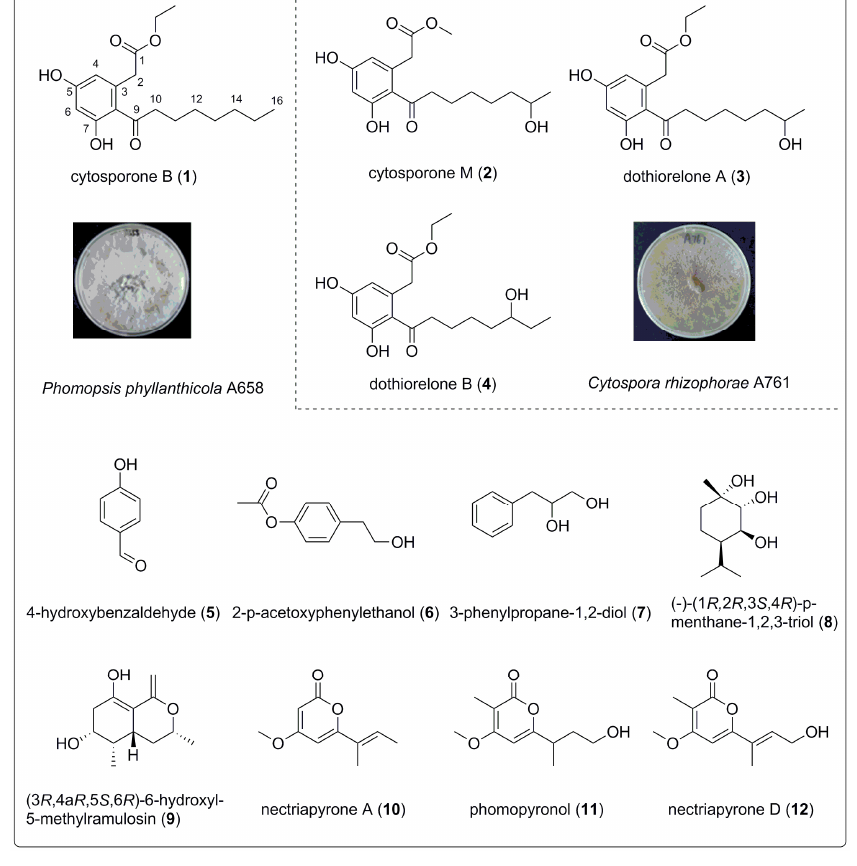
Figure Figure 1. Structures of compounds 1 – 12 (compounds 1 and 5 – 12 were isolated from A658, and compounds 2 – 4 were isolated from A761).